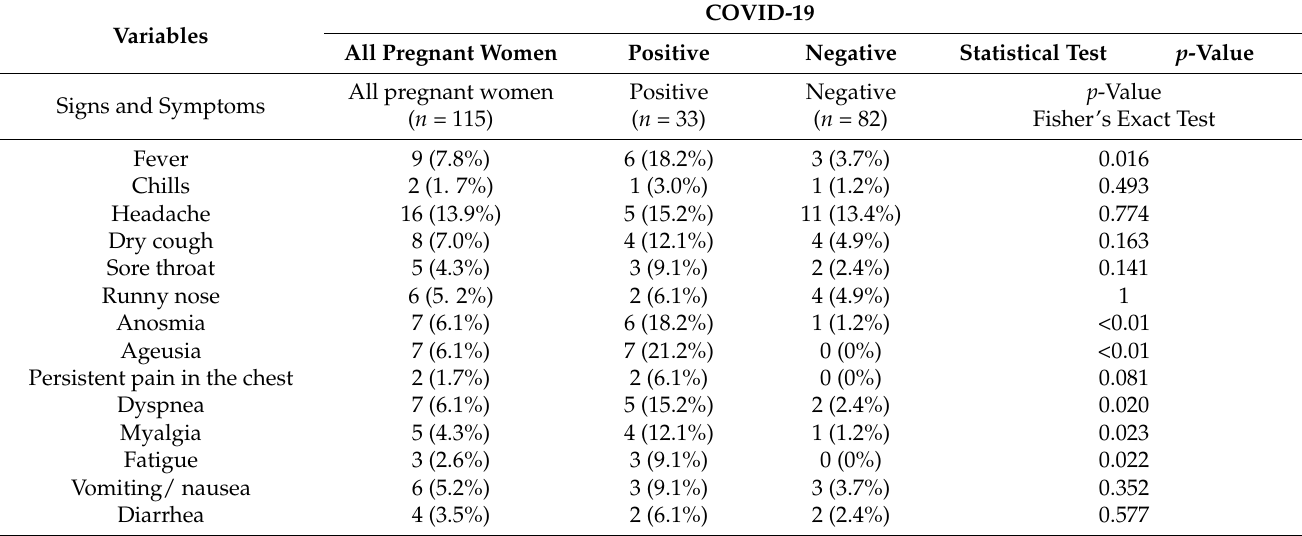
Table 2. Maternal signs and